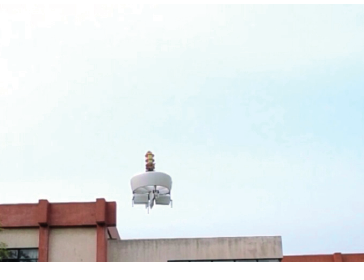
Figure 4. Flight test.